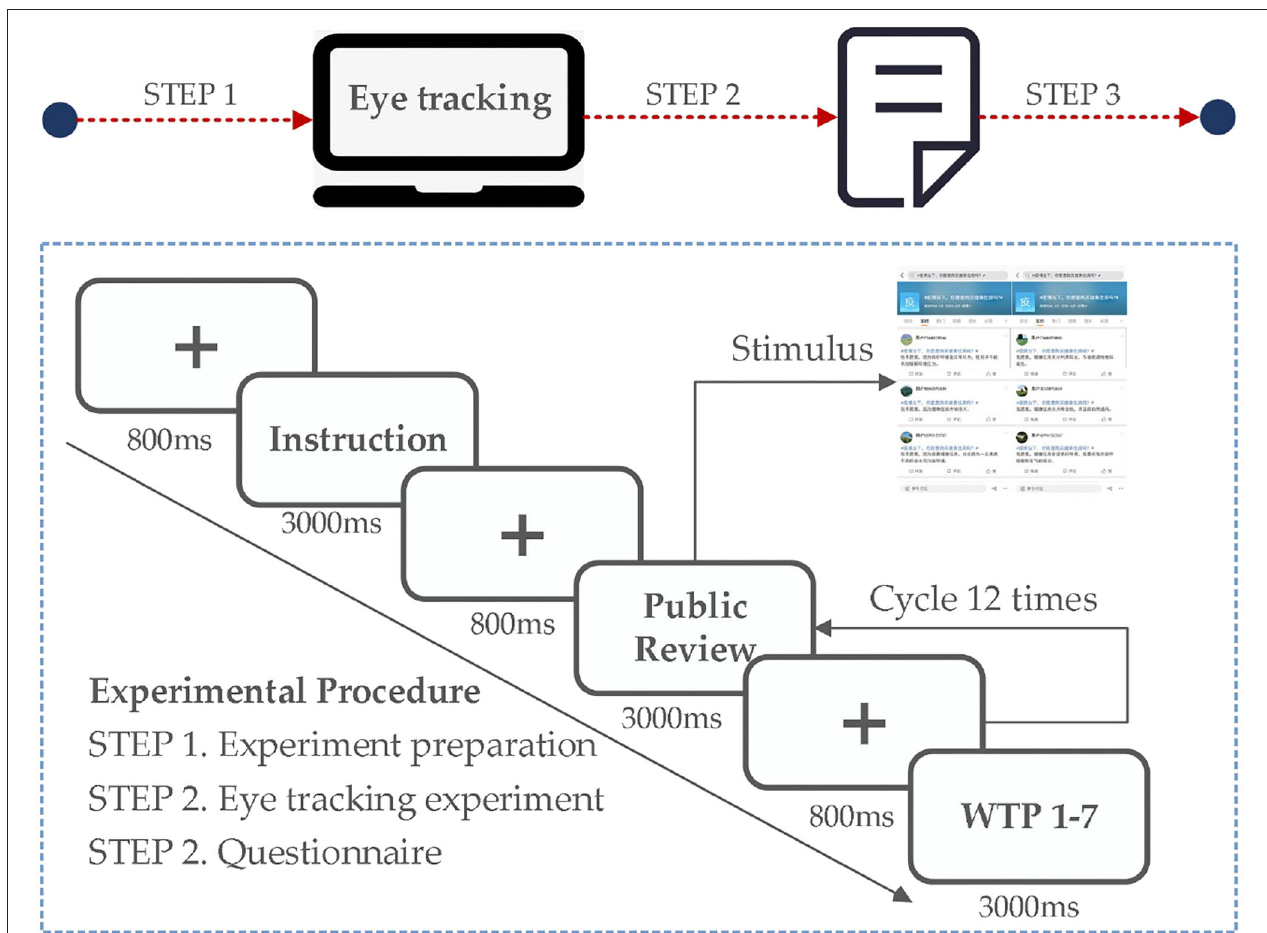
FIGURE 3 | Experimental